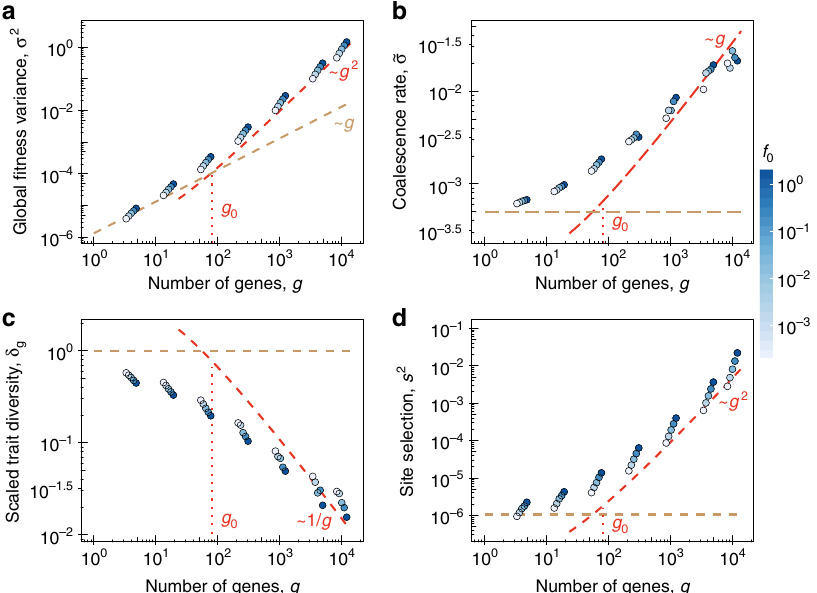
Fig. 2 Global and local scaling under phenotypic interference. Average population data are plotted against the number of genes, g , for the minimal biophysical model at steady-state asexual evolution. Simulation data (circles) for different average gene selection coef fi cients f 0 (indicated by color) show a crossover from the regime of independently evolving genes (brown dashed lines) to phenotypic interference (red dashed lines). The error bars (SD) are smaller than or equal the diameter of the symbols. The crossover point g 0 (cid:7) 10 2 is marked. a , b Global observables. Average total fi tness variance, σ 2 , and coalescence rate, ~ σ ; phenotypic interference scaling σ 2 (cid:7) g 2 = c and ~ σ (cid:7) g = c (red dashed lines) as given by Eqs. 5, 7 with a fi t parameter c 0 (cid:4) 80. c , d Local ¼ Δ = ϵ 2 observables. Average scaled trait diversity δ and mean square selection coef fi cient at sequence sites s 2 ; phenotypic interference scaling G G G δ (cid:7) c = g and s 2 ¼ 4 ~ σ 2 (cid:7) g 2 = c 2 (red dashed lines) as given by Eqs. 6, 7. Values δ G G < 1 indicate that individual proteins are in the low-mutation regime. The scaling s 2 (cid:7) ~ σ 2 is independent of f 0 , signaling that site selection coef fi cients emerge from a feedback between global and local selection (see text). Other simulation parameters: N ¼ 1000, u ¼ 1 : 25 ´ 10 (cid:2) 3 , ϵ G = k T ¼ 1; see Methods section for simulation details. Supplementary Fig. 2 shows global and B